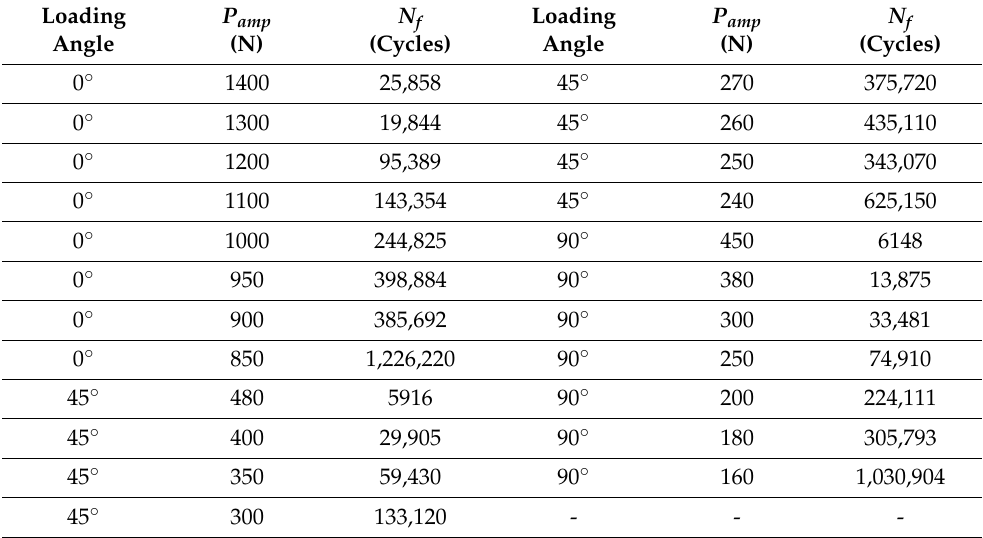
Figure 11. Comparison of the load amplitude against the number of cycle plots for SPR joints at different loading angles. different loading angles. Table 4. Experimental fatigue lifetime data of SPR joints under various loading angles.